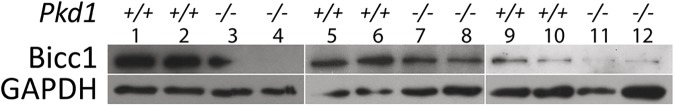
Bicc1 downregulation in Pkd1-/- mice.(A) In accordance to our analyses of human microarrays of PKD patients, Bicc1 immunoblots of kidney extracts from newborn littermates Pkd+/+ and Pkd1-/- showed that all Pkd1-/- renal tissues exhibited considerable Bicc1 downregulation. GAPDH: loading control.